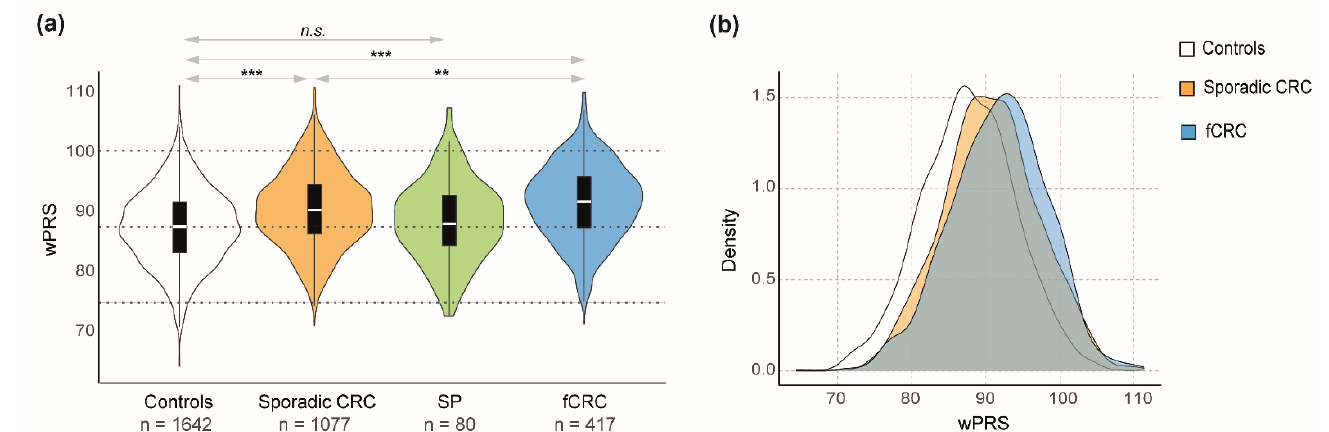
Figure 1. ( a ) Combined violin and box plots showing wPRS values for each group. Dotted lines indicate the median ± 2 standard deviations (SD) for controls. *** p < 0.001; ** p < 0.01; n.s. non-significant, based on t -test results (Table 2). ( b ) 92- variant-based wPRS plotted against the density in controls (white), sporadic CRC (orange) and fCRC (blue). Abbreviations: CRC, colorectal cancer; SP, serrated polyposis; fCRC, familial/early-onset colorectal cancer; wPRS, weighted PRS. Table 2. Descriptive analysis of the groups according to the 92-variant-based wPRS. Each cohort is compared with the control group. Group Controls 1077